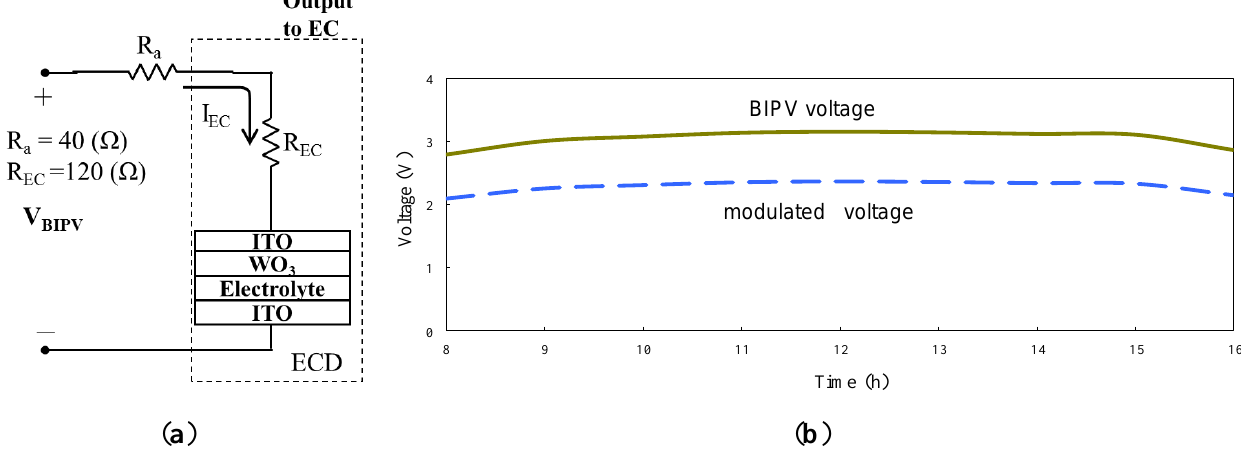
Figure 12. ( a ) Layout of divider circuit in voltage controller, and ( b ) variations of original and modulated output voltages from BIPV panel between 8:00 am and 4:00 pm during a typical summer day.